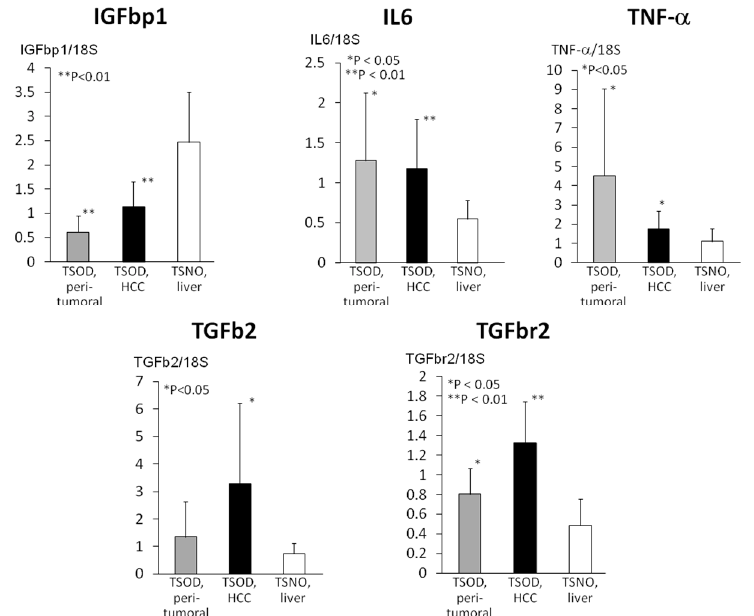
Figure 5. Insulin-like growth factor binding protein 1 ( IGFbp1 ), interleukin 6 ( IL6 ), tumor necrosis factor alpha (TNF- α ), transforming growth factor b2 ( TGFb2 ), and transforming growth factor binding receptor 2 ( TGFbr2 ) mRNA expression changes in TSOD mice livers and tumors. Note the significant decrease of IGFbp1 in TSOD mice livers and HCCs, associated with significant elevation of markers of inflammation (IL6, TNF- α ), and fibrosis (TGFb2 and